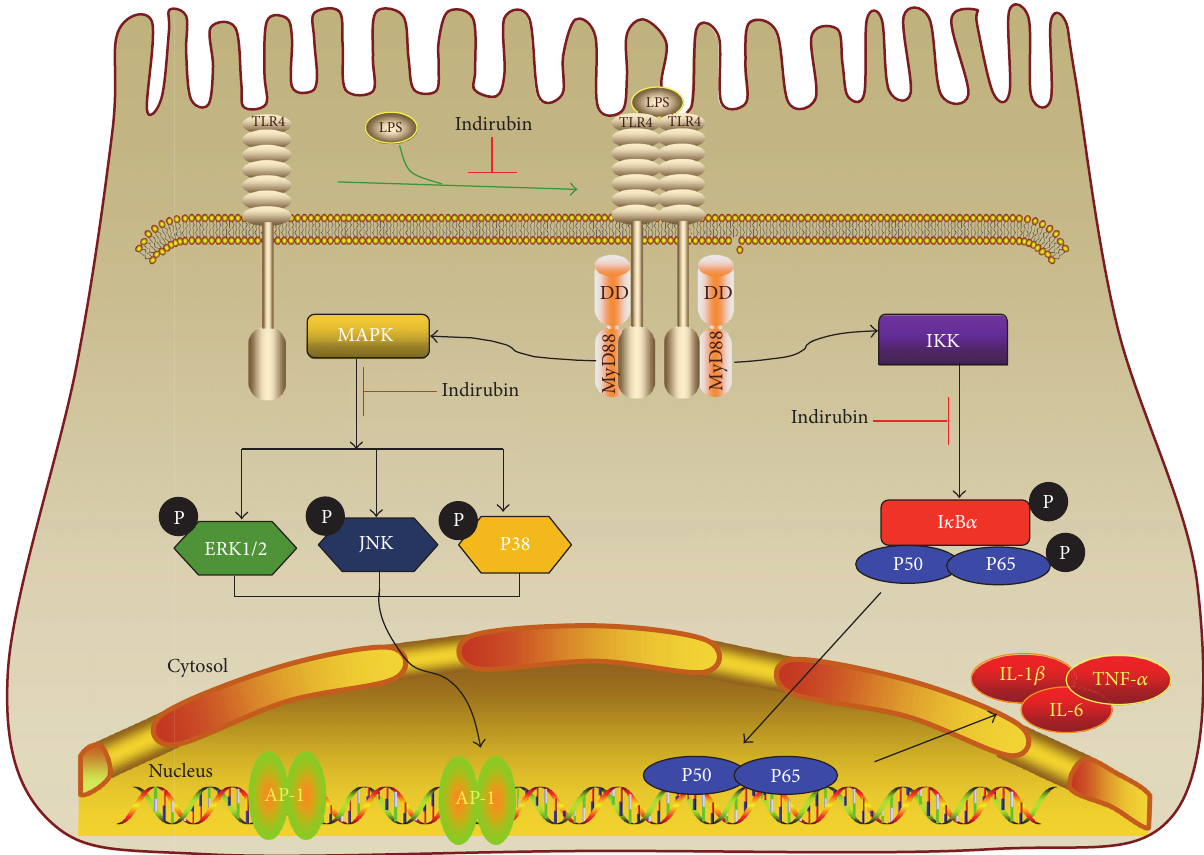
Figure 8: Indirubin treatment of lipopolysaccharide induced mastitis in a mouse model and activity in mouse mammary epithelial cells via bated TLR4 and its two main Myd88-dependent pathways, NF- 𝜅 B and MAPK.